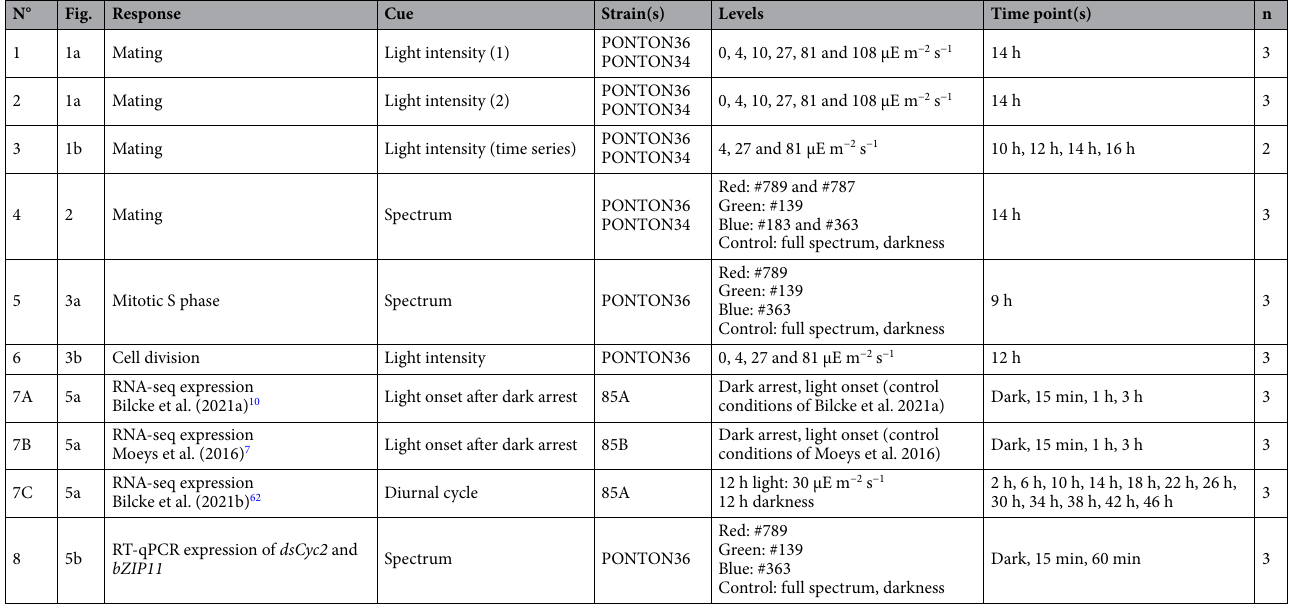
Table 1. Overview of experiments (rows) included in this study. The column “Fig.” indicates the figure where results of each experiment are presented. “Response” gives the response that was quantified, while “Cue” and “Levels” contain the type and treatment levels of the experimental condition (for spectral experiments, the Lee Filters IDs are given). “Strain(s)” shows the S. robusta strain that was used for each experiment. “Time point” indicates the duration of light treatment after which response was quantified. The number of replicates per treatment/time point is shown in column “n”. Data for expression analyses (N° 7) was retrieved from existing transcriptomic studies, as shown in the “Response”